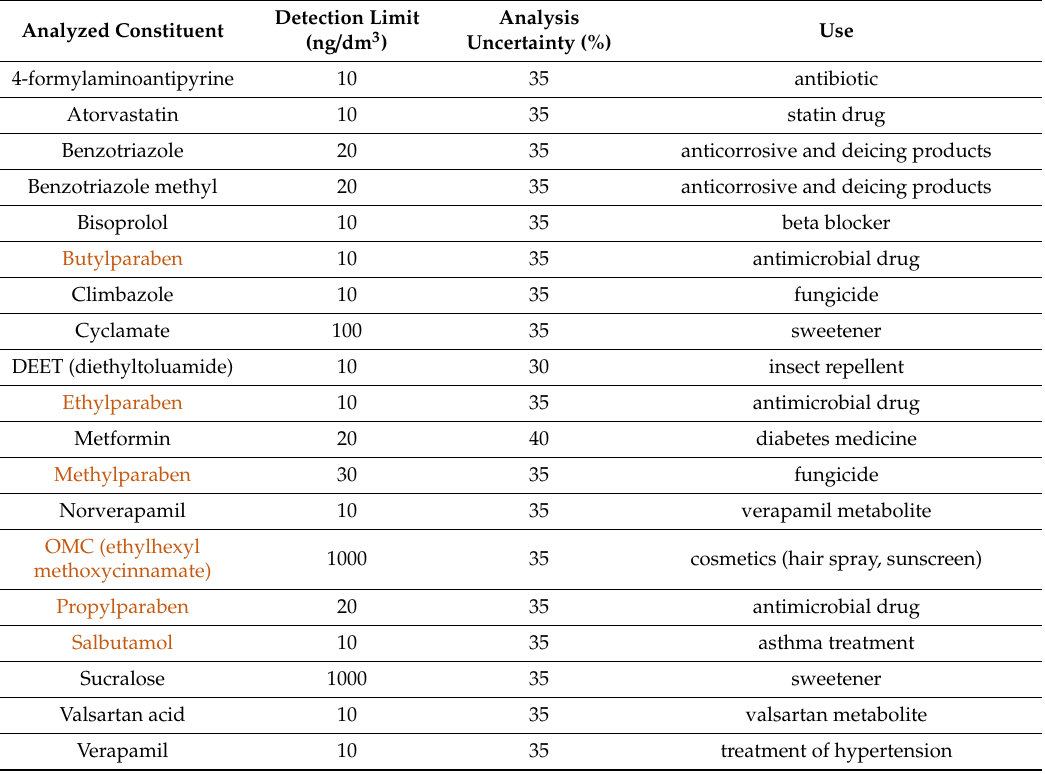
Table 2. List of analyzed PPCP constituents analyzed in 2019 in addition to 2017–2018 monitoring. Substances with concentration mostly below the detection limit (95–100% of samples) are marked in